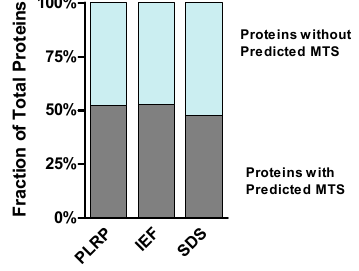
Figure 5. Distribution of proteins according to the presence of N -terminal mitochondrial targeting sequence